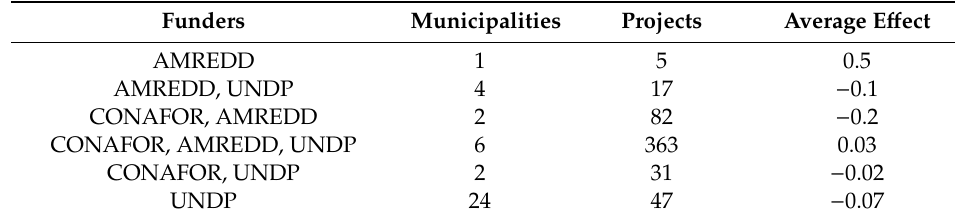
Table 4. Average REDD + e ff ect on the municipal deforestation rate as per intervening funders and number of associated projects (CONAFOR = National Forestry Commission, UNDP = United Nations Development Program, AMREDD = Mexico REDD + Alliance).